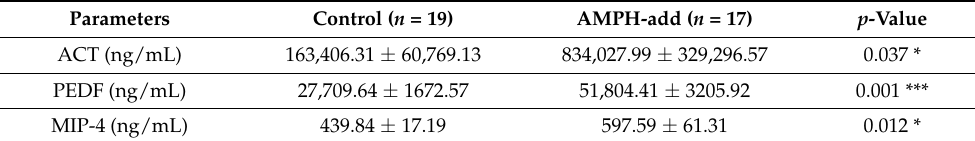
Table 2. Biomarkers and proinflammatory cytokines from AMPH-adds’ serum and control subjects. Parameters